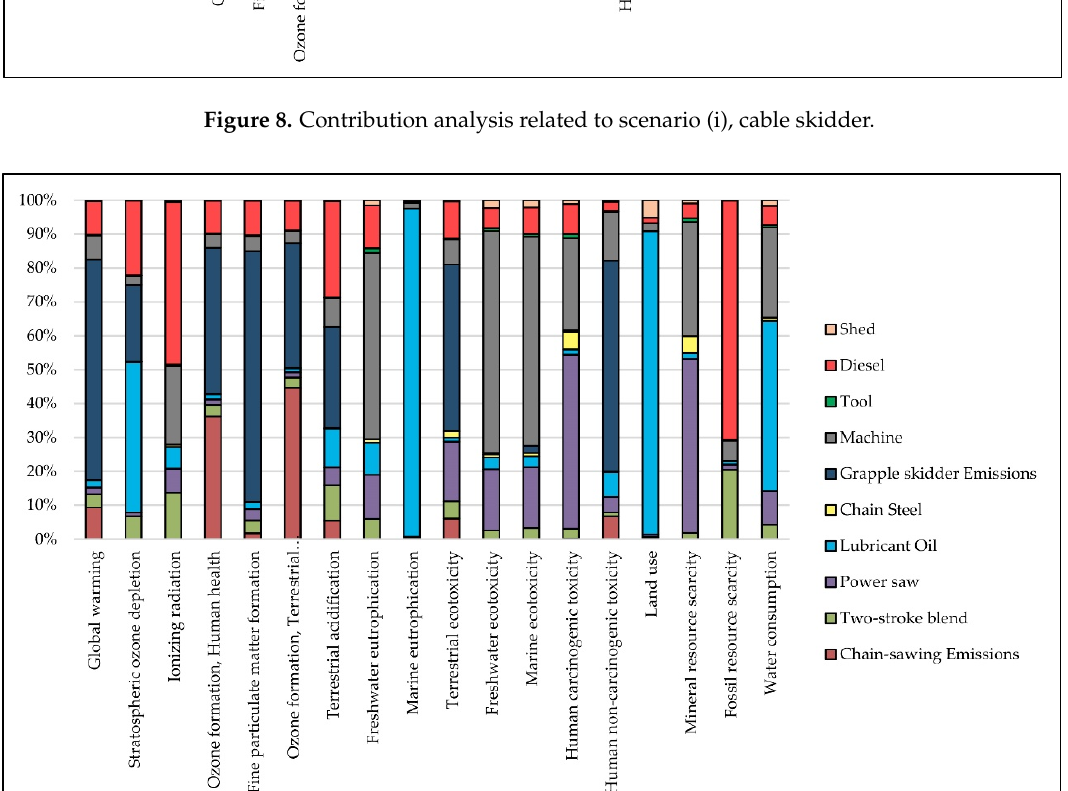
Figure 10. Contribution analysis related to scenario (iii), forwarder. The impacts on eutrophication in freshwater and marine waters, the former due to machinery construction and the latter to lubricating oil production, are negligible in entity (Tables 6 and 7). The impacts on the three ecotoxicity indicators (marine, terrestrial and freshwater) and on human carcinogenic toxicity are mainly due to the heavy metal emis ‐ sions generated during chainsaw, skidder and forwarder manufacturing. Heavy metals (particularly lead and zinc) fuel combustion emissions as well as soil emissions from tyre wear are the main impactful factors in the “Human noncarcinogenic toxicity” category. Resource consumption impacts are mainly generated by the production processes of the inputs used in the logging process. In terms of land use and water consumption, the im ‐ pacts are mainly attributable to the production process of vegetal lubricating oil. Key